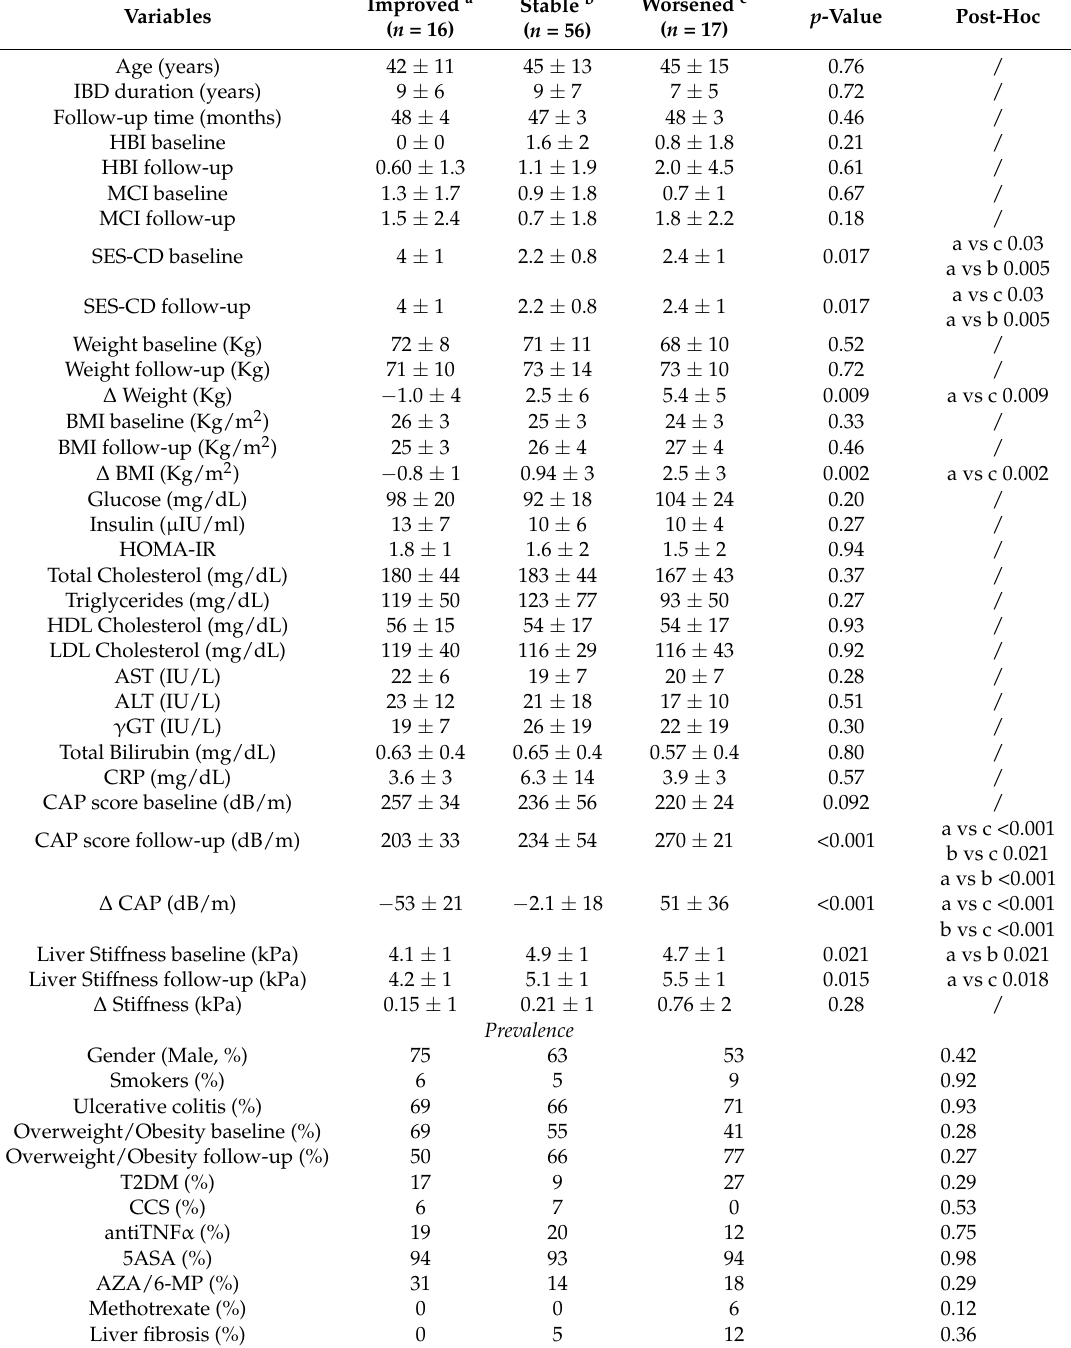
Table 2. Demographic and clinical characteristics of the Inflammatory Bowel Disease population according to the categorisation (improved, stable and